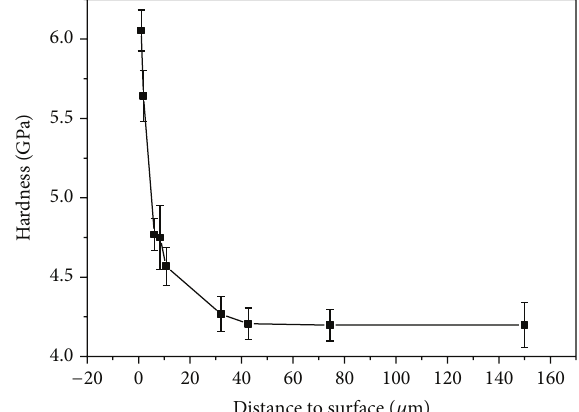
Figure 6: Curve of the hardness that corresponds to distance to the surface.